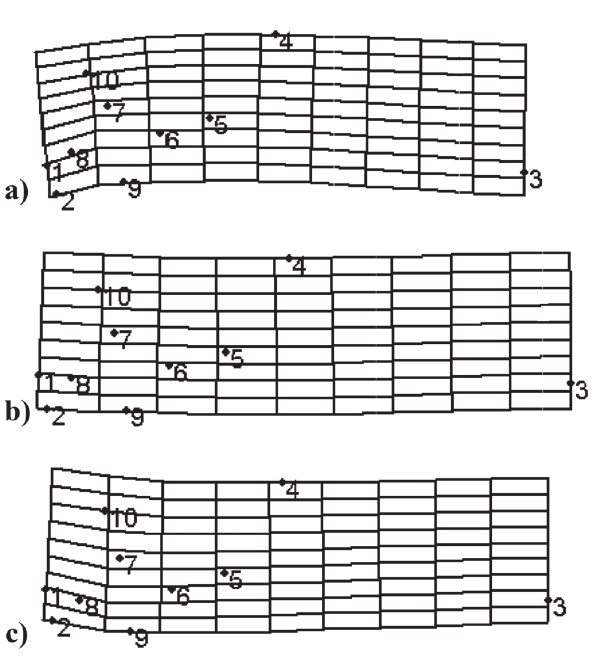
Fig. 4. Deformations grids for newly hatched embryos, with different DAF (15, 16, and 17), incubated at the same temperature (18ºC): a ) AH 1, b ) AH 2, and c ) AH 3 (see comparison AH in Table